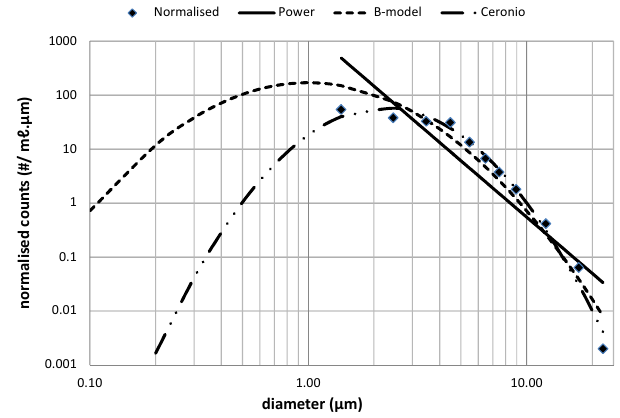
Figure 1. The power law, the variable- β model and the Ceronio model, fitted to the same particle